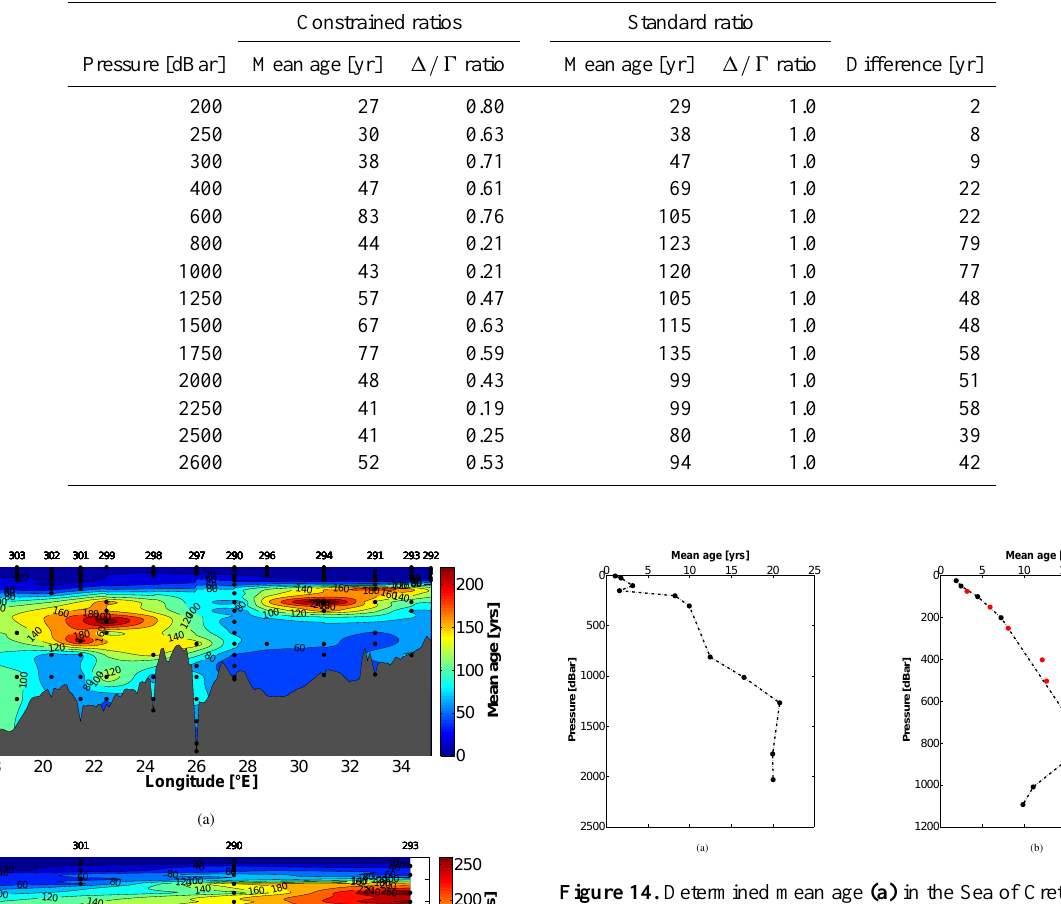
Table 3. Comparison of mean age results between a TTD model with constrained 1/0 ratios and a TTD model with standard ratio 1/0 = 1 . 0 (Schneider et al., 2014).